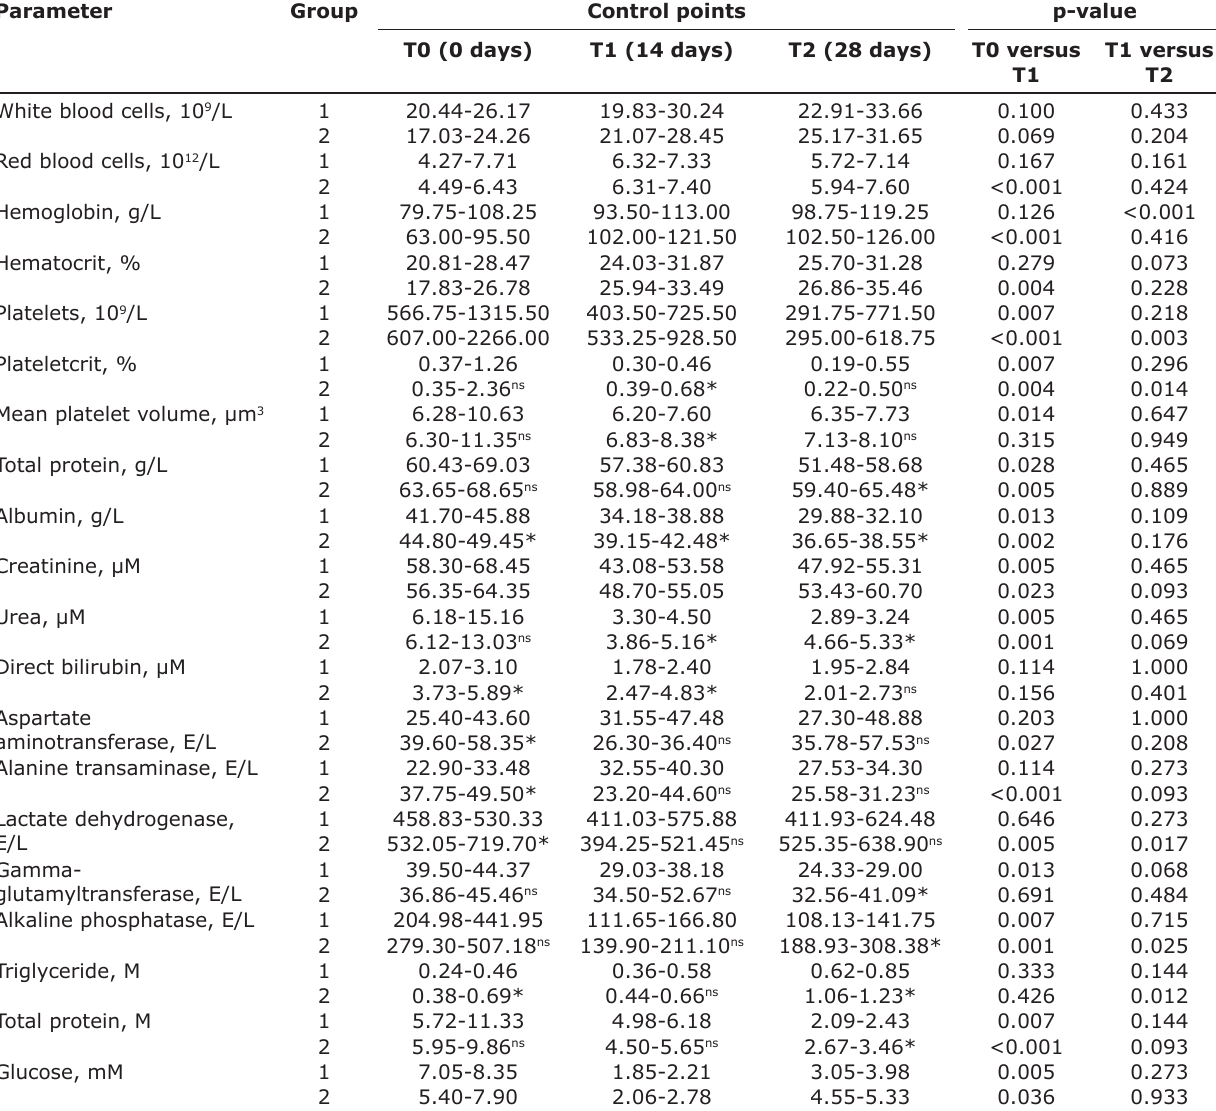
Table-4: Hematological parameters and serum biochemistry of experimental piglets (P25-P75).